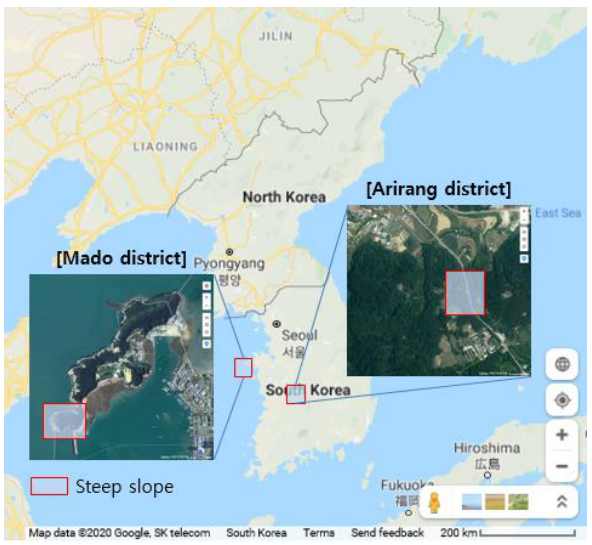
Figure 2. Site location of steep slope in this study